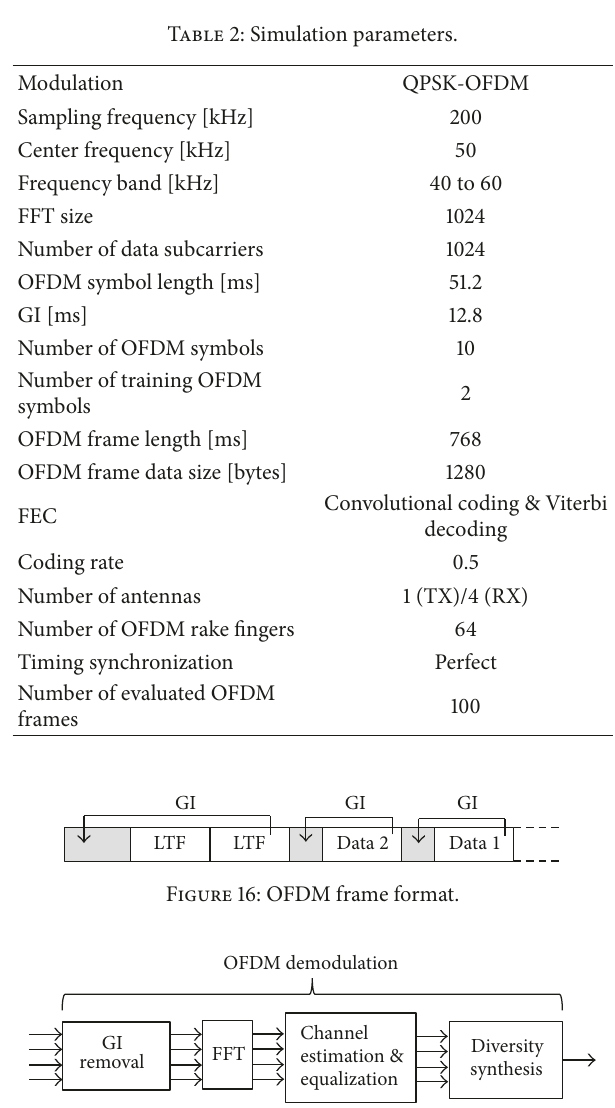
Figure 17: OFDM space